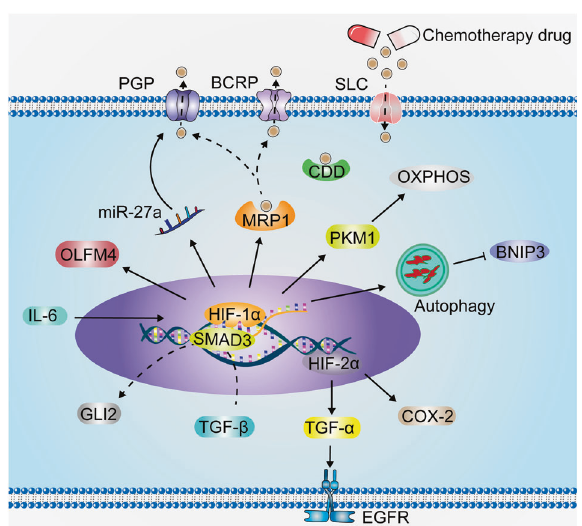
stimulates HIF-1 α expression, which increases PGP